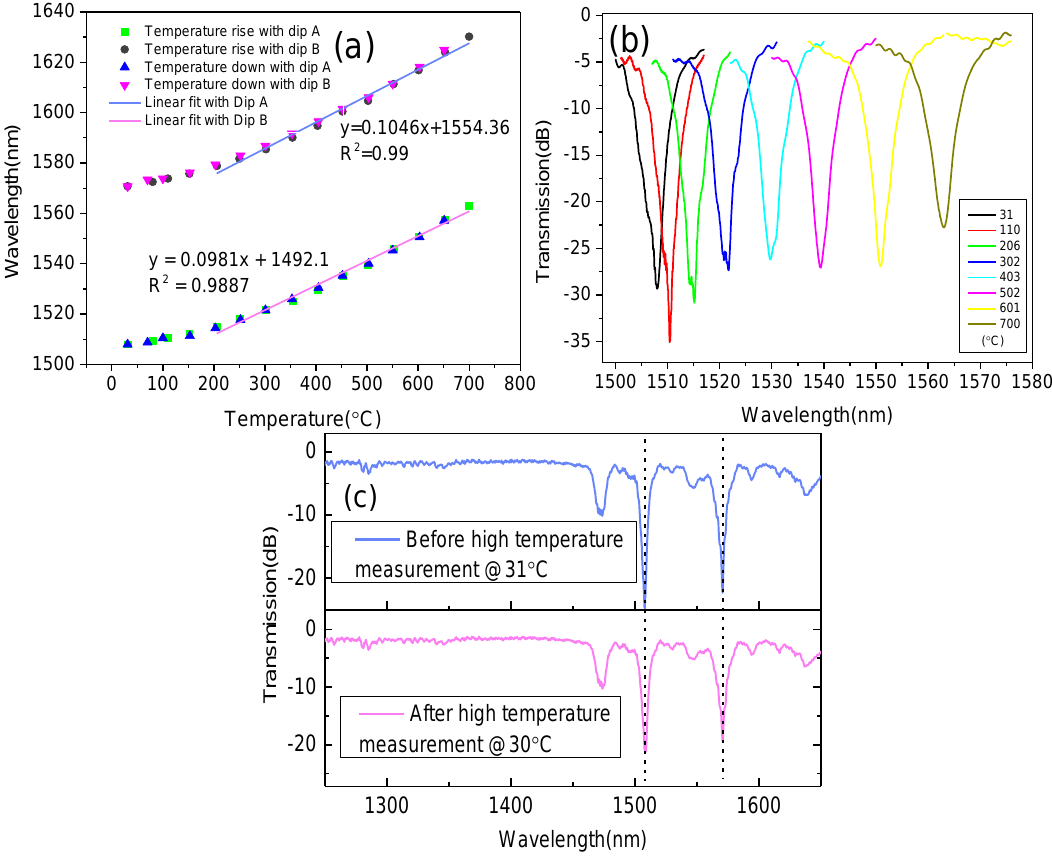
Figure 4. Variation of ( a ) the center wavelength of the LPFG and ( b ) its spectrum with temperature; and ( c ) the comparison with the spectra of the LPFG before and after high-temperature measurement.